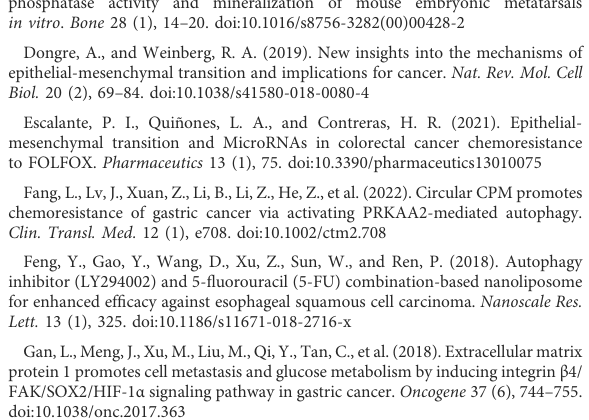
SUPPLEMENTARY FIGURE S1 ECM1 enhances CRC cell resistance to 5-FU via the PI3K/AKT/GSK3 β pathway.AfterbeingtreatedwithPI3Kagonist(740Y-P)orPI3Kinhibitor (LY294002) for 24 h, the CCK8 assay was used to detect the change in drugsensitivity. (A) theeffectsof740Y-Pon5-FUresistanceinHCT15/FU cells. (B) the effect of PI3K LY294002 on 5-FU sensitivity of HCT15 cells. SUPPLEMENTARY FIGURE S2 Inhibiting PI3K/AKT pathway activation reversed the harmful effects of ECM1 overexpression in 5-FU-treated HCT15 cells. (A,B) PI3K/AKT- relatedproteinexpressionwasdetectedfollowingLY294002treatment for 24 h to con fi rm treatment ef fi cacy. (C – G) Following LY294002 treatment, the migratory and invasive activity levels of HCT1- ECM1 cells were examined through wound healing, Transwell assays, TUNEL labeling and fl ow cytometric studies revealed that these cells had undergone apoptosis (H – K) Western immunoblotting was used to identify proteins involved in EMT and apoptosis. The data are shown as means ± SD (* p < 0.05, ** p < 0.01, *** p < 0.001, **** p <